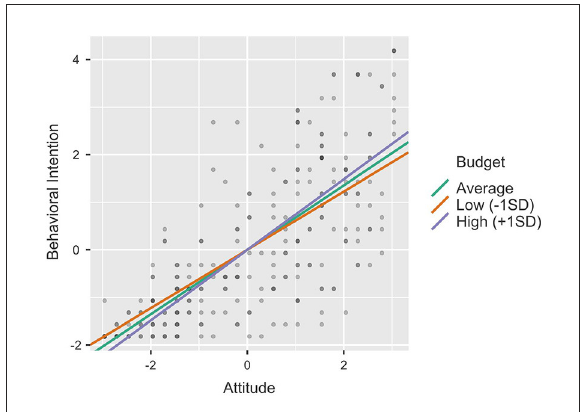
FIGURE3 Single slope plot—Budget.